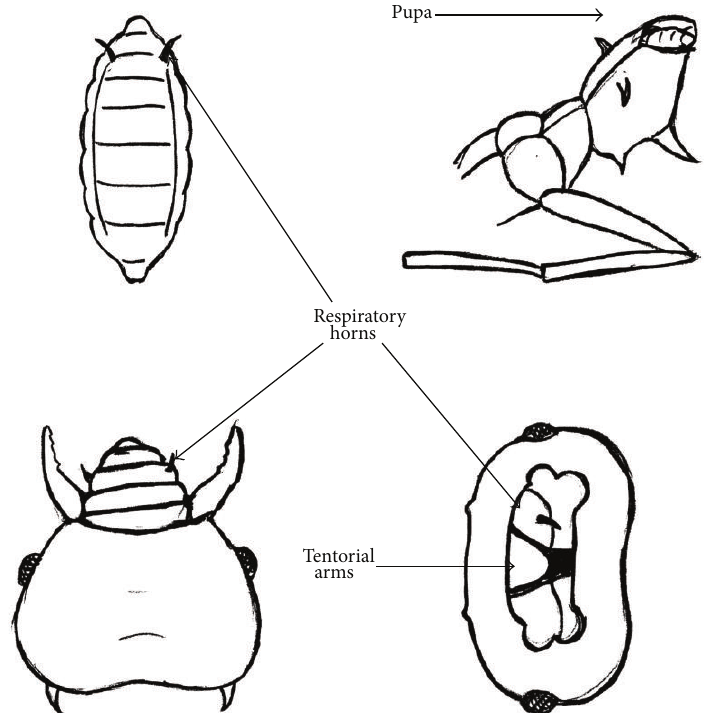
Figure 3: Schematic drawings showing different types of pupae according to the parasitoid genus. Top left: Dorsal view of a free pupae from Apocephalus , top right: claustral thoracic pupae from Apocephalus vicosae , viewed from ventral side, bottom left: claustral pupae from Eibesfeldtphora and Neodohrniphora coming out of the ant head between the mandibles (ventral view), and bottom right: claustral pupae from Myrmosicarius, viewed within ant head, under the tentorial arms (modified from